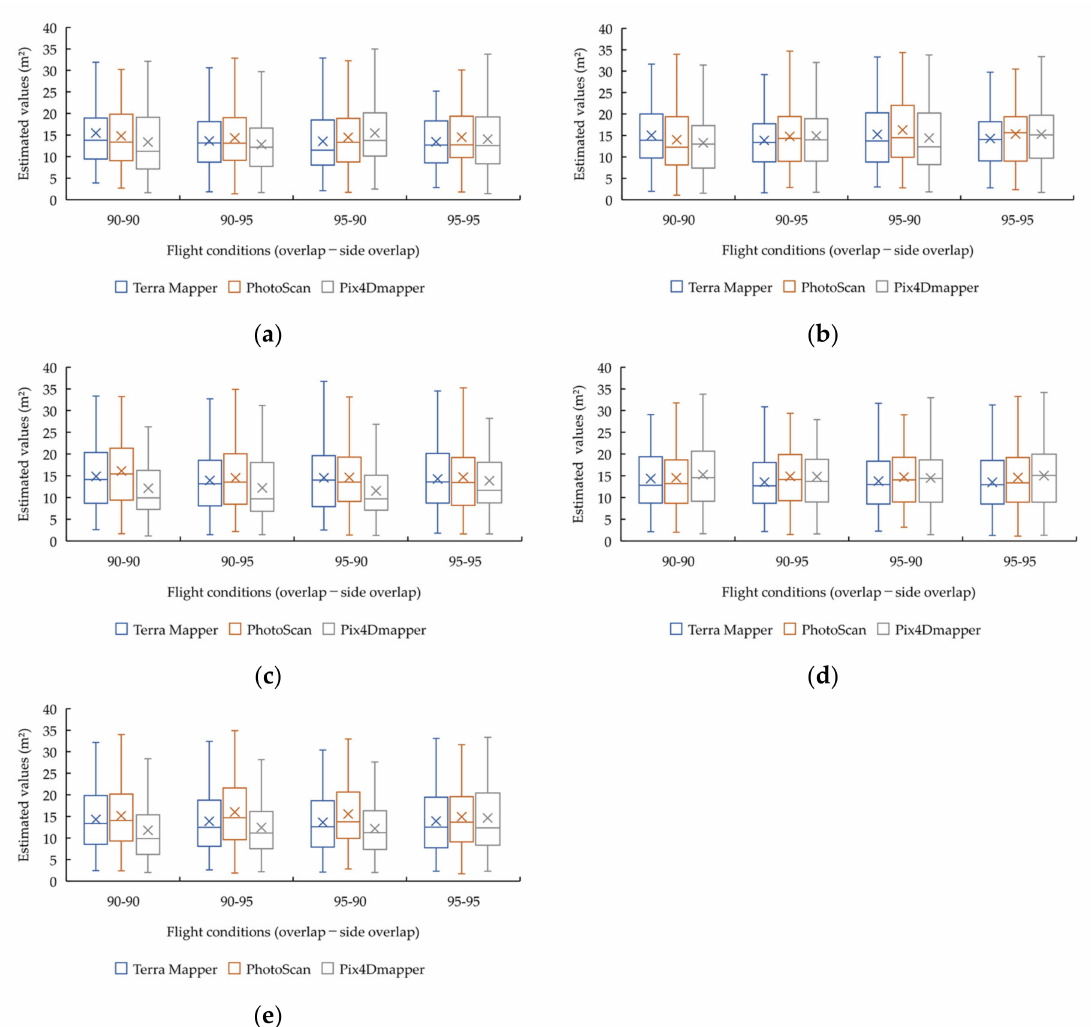
Figure 7. Estimated value of the crown area from each SfM software package: ( a ) flight altitude = 60 m; ( b ) flight altitude = 80 m; ( c ) flight altitude = 100 m; ( d ) flight altitude = 120 m; and ( e ) flight altitude = 140